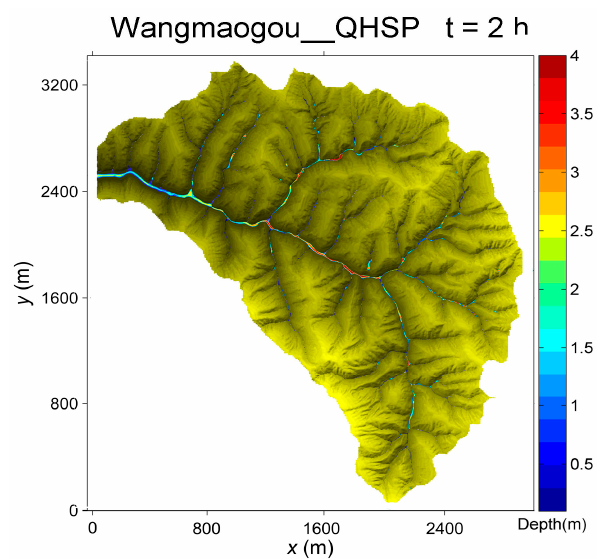
Figure 16. Flood simulation on the DEM constructed by using QHSP method at t = 2.